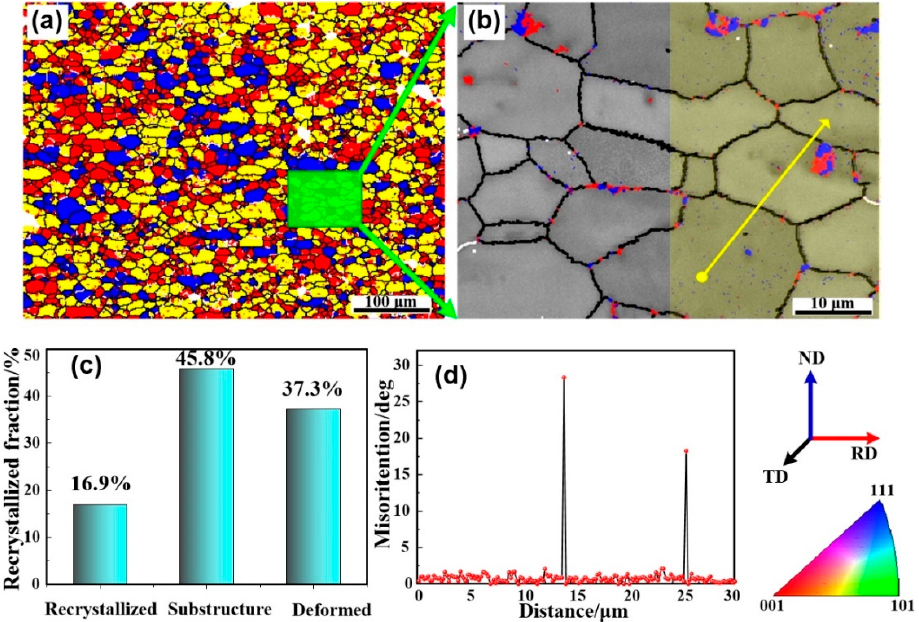
Figure 8. ( a ) Grain boundary (GB) maps overlaid with recrystallized microstructure of the 5 wt.% nanosized TiB 2 /AA2219 composite, in which fully recrystallized grains are in blue, deformed regions in red and substructured grains in yellow, ( b ) Electron backscatter diffraction maps of the composite, the blue and red represent nanoparticles and Al 2 Cu phases, ( c ) recrystallized fraction of the composite, and ( d ) misorientation profiles measured along yellow line.